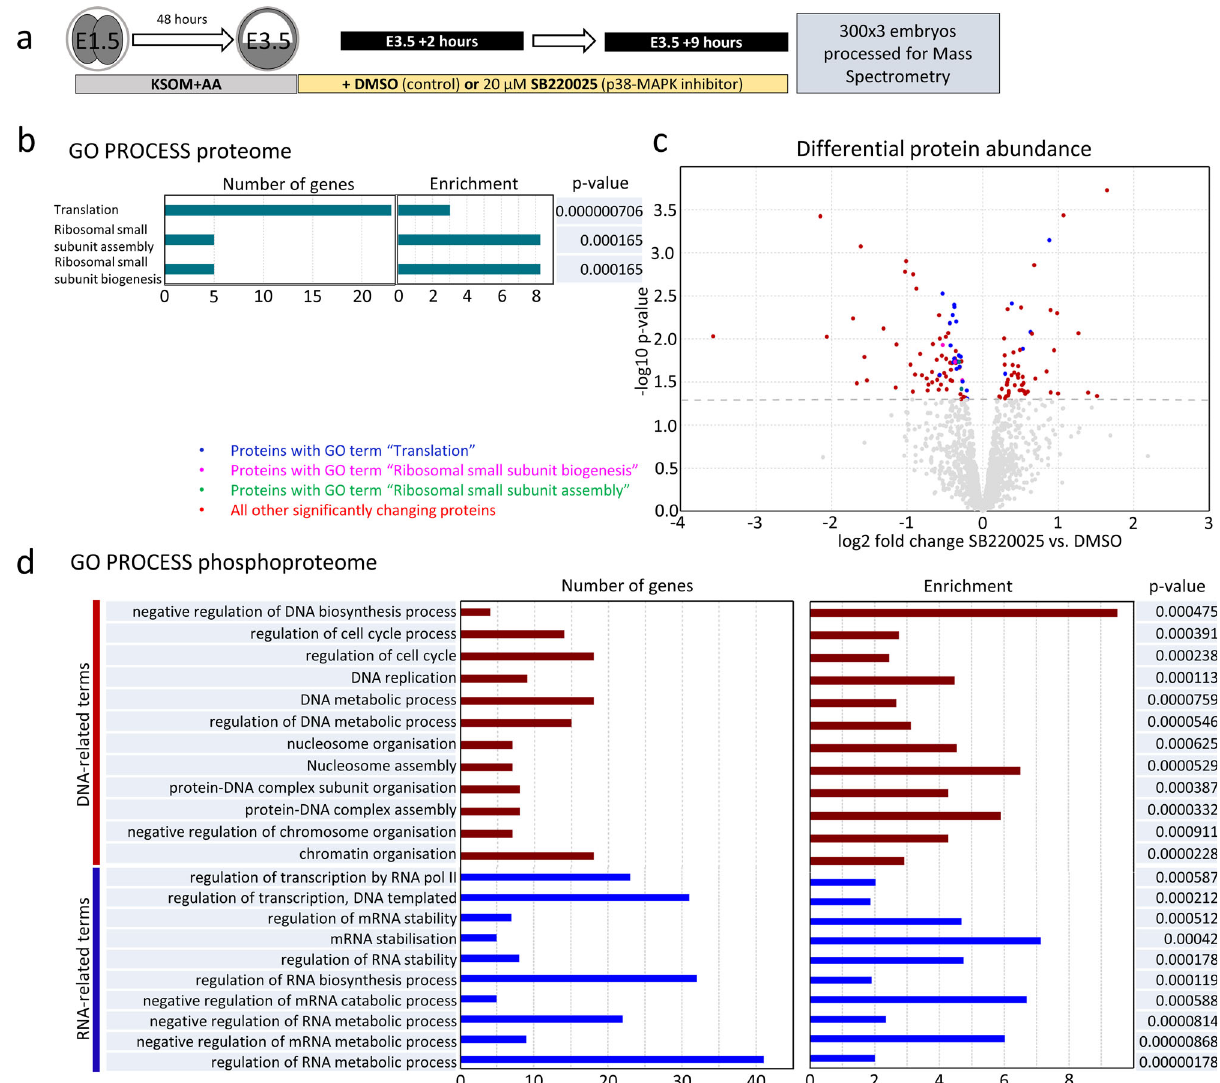
Fig. 2 Proteomic and phosphoproteomic analyses of the effects of p38-MAPKi in developing blastocysts. a Experimental design of sample collection for control (DMSO; n = 3 (300 embryos per repeat)) and p38-MAPKi (SB220025; n = 3 (300 embryos per repeat)) blastocysts after 7 h of chemical exposure (at E3.5 + 9 h) prior to mass spectrometric analysis of the (phospho-)proteome (300 blastocysts per condition were tested in biological triplicates). b The most statistically signi fi cantly enriched GO terms for the differentially detected proteins between control and p38-MAPKi blastocysts. c Volcano plot of the detected differentially expressed proteins associated with p38-MAPKi. Proteins associated with the indicated enriched GO terms are highlighted in blue (translation), purple (ribosomal small subunit biogenesis), and green (ribosomal small subunit assembly) (note that there is overlap — see Supplementary Data 1); the proteins associated with other terms are in red, while the proteins that were not statistically signi fi cantly changed are in gray. d Statistically signi fi cantly enriched GO terms for the differentially detected phosphopeptides between control and p38-MAPKi